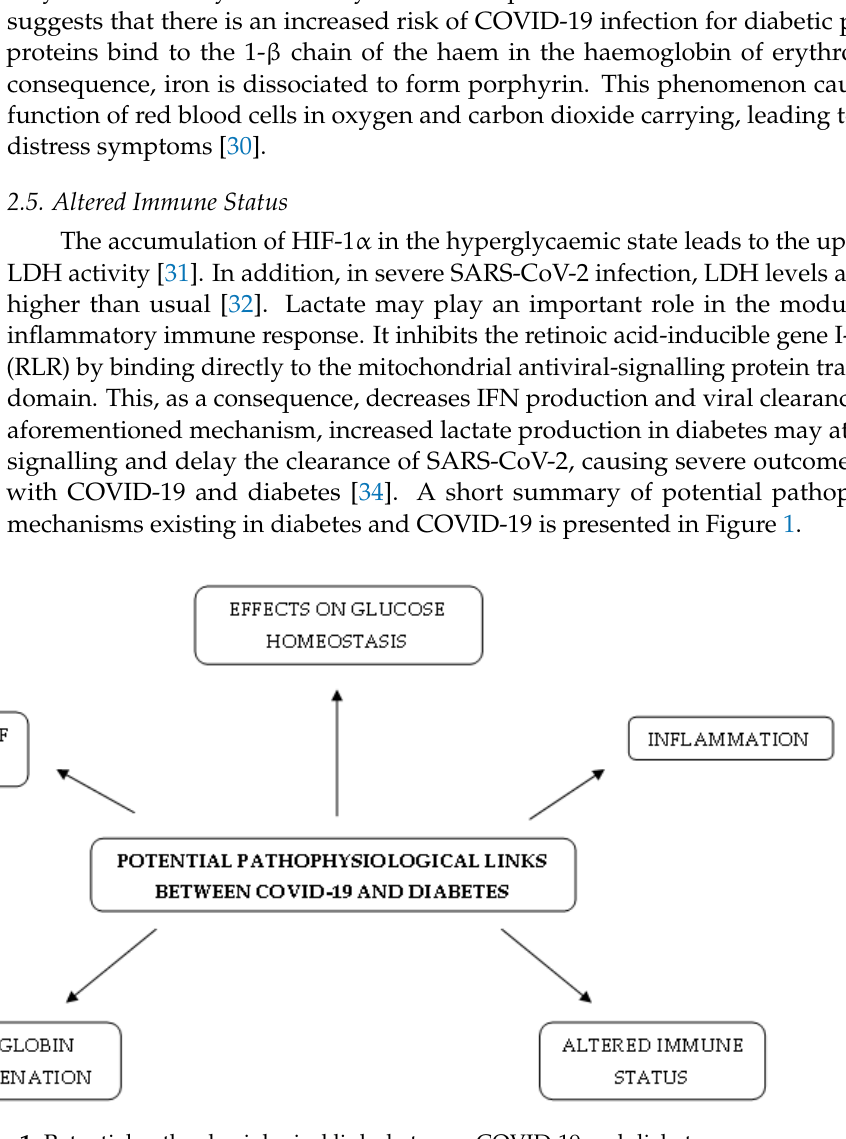
Figure 1. Potential pathophysiological links between COVID-19 and diabetes.